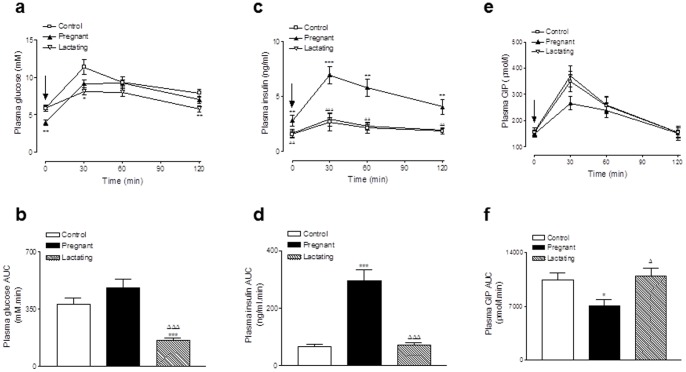
Effects of pregnancy and lactation on (a,b) glycaemic, (c,d) insulin and (e,f) GIP responses to oral glucose in Wistar rats.Tests were conducted on days 21 and 42 in overnight fasted rats. Oral glucose (51.2 kJ/kg body weight) was administered at the time indicated by the arrow. Plasma glucose, insulin and GIP AUC values for 0–120 min are also shown Values are means ± SEM for 6 rats. * p<0.01, ** p<0.01 and *** p<0.001 compared to controls. Δ p<0.05, ΔΔ p<0.01 and ΔΔΔ p<0.001 compared to pregnant rats.